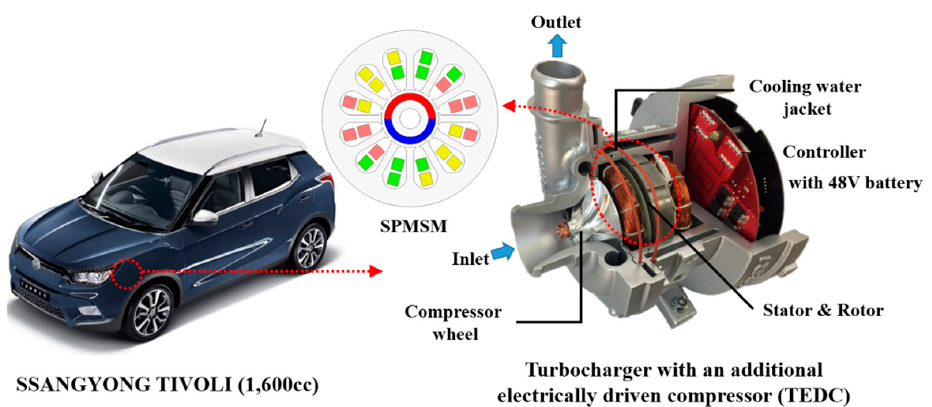
Figure 2. KERI and Keyyang Precision’s turbocharger with an additional electrically driven com- pressor